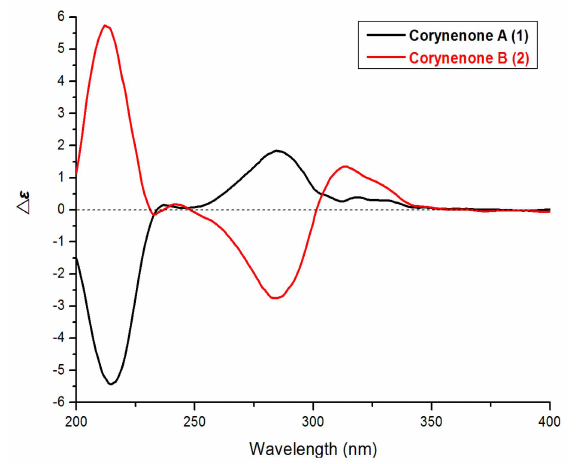
Figure 3. ECD spectra of 1 and 2